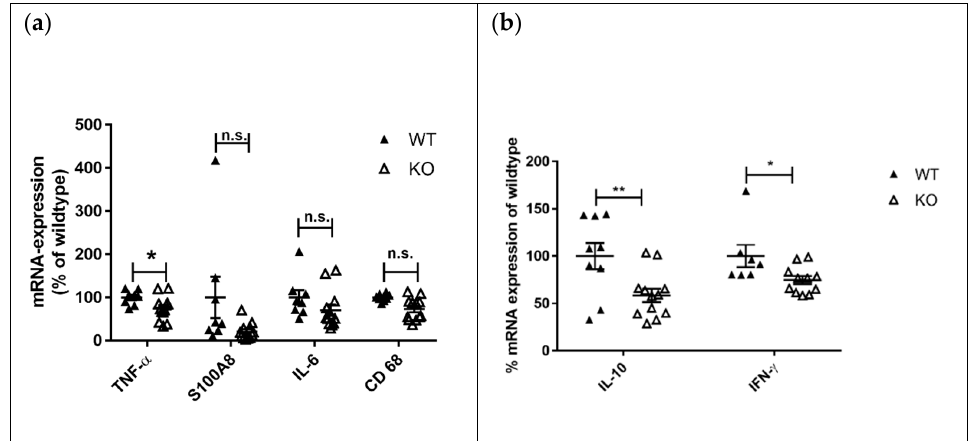
Figure 8. Analysis of mRNA expression of disease-relevant markers in the lymph nodes of 19-week-old female MRL-Fas lpr KSRP − / − mice compared to MRL-Fas lpr KSRP +/+ mice. RNA was isolated from lymph nodes ( a , b ) of 19-week-old female MRL-Fas lpr KSRP − / − mice (KO) and MRL-Fas lpr KSRP +/+ mice (WT). The mRNA expression of TNF- α , S100A8, IL-6, CD68, IL-10 and IFN- γ was analyzed by qRT-PCR and normalized to the mRNA expression of Pol2a. Data presented are the mean ± SEM of the relative mRNA expressions based on WT (100%) with 8 to 12 animals per genotype (**: p < 0.01; *: p < 0.05; n.s.: not significantly different from WT, t -test).